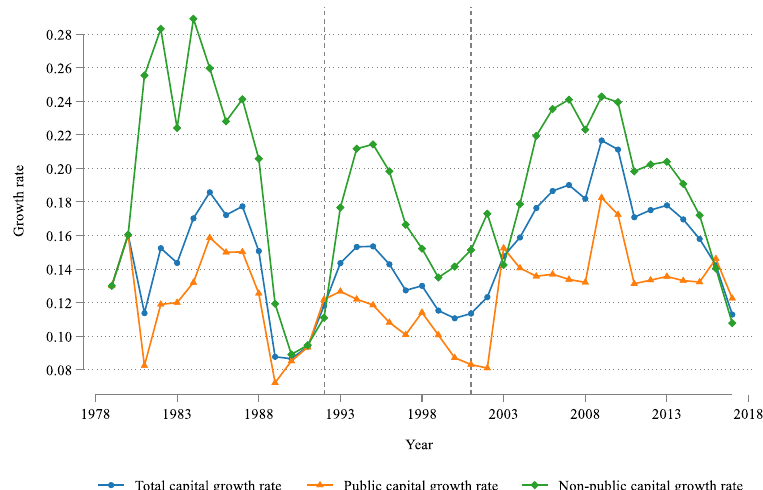
Figure 1. Overview of inventory capital.